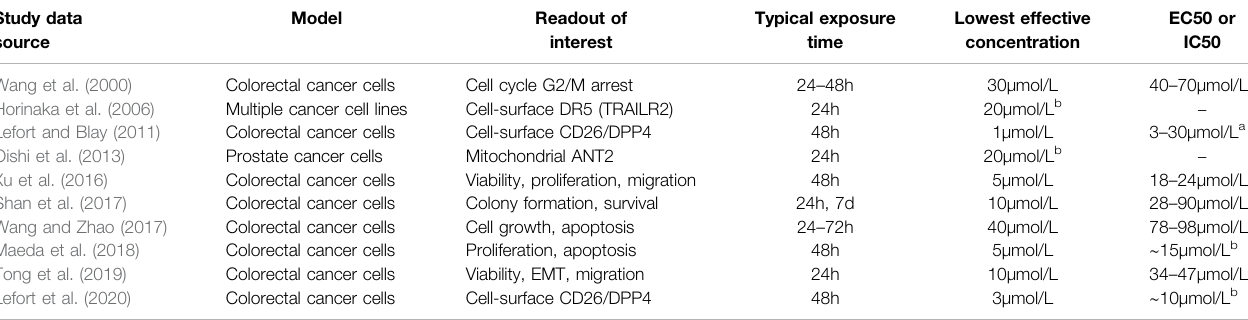
TABLE 4 | Concentrations of apigenin necessary to produce cellular responses in human cancer cells. A representative series of examples were taken from the literature citedinthisreview.Themainexperimentalreadoutsareindicated,althoughstudiesincludedmoredetail.Alltargetsarehumancells,andinallcasesinvolveasingledose of apigenin except for one example in which colony formation was evaluated over seven days and apigenin was added on a daily basis (Shan et al.,